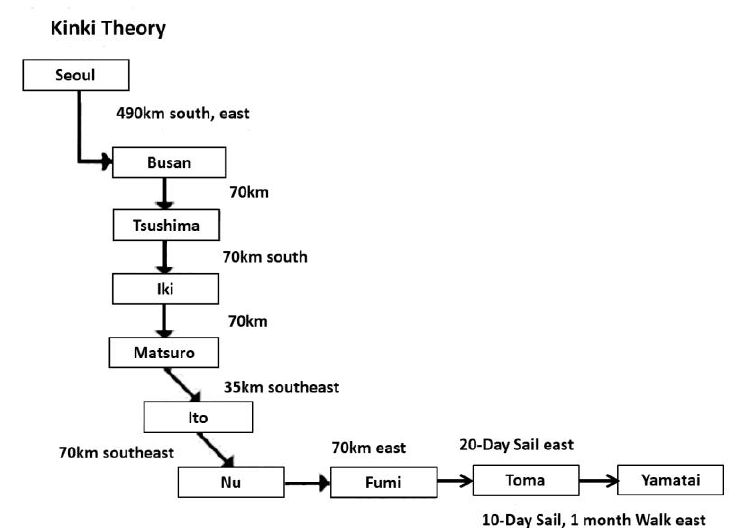
Figure C1. Three theories developed from Sanguozhi : Continuous theory (left upper), Radiated Theory (right upper), Kinki theory. Japanese historians had discussed the location of Yamatai for the past more than 100 years, but nobody solved it. They proposed three theories as shown in Figure C1. All historians ignored a parameter, family numbers, which were described in Sanguozhi. The authors introduced this parameter into multivariate analysis with normalized root-square-mean errors, RMS for three theories. Continuous Theory determined the locations of Yamatai countries in the same order as described in Sanguozhi, while Radiated Theory changed Ito country as the center of Yamatai adjusting real locations of Kyushu. However, Kinki Theory ignored the directions of the countries described in Sanguozhi adjusting real locations of Kinki. Kyushu is a big island and Kinki is the western part of Japan. The relationship between Yamatai and Japanese emperors was still